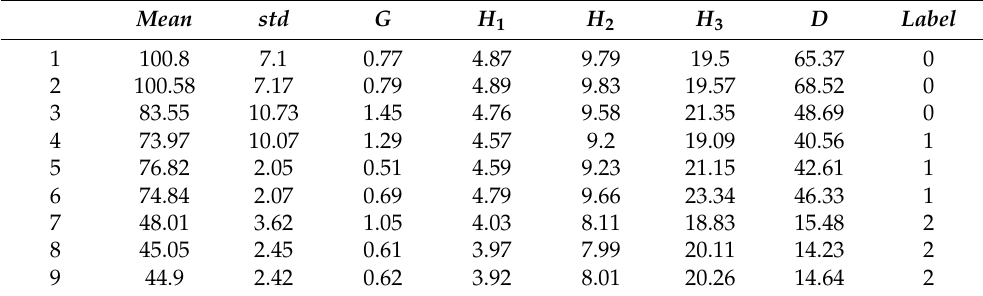
Table 1. Results of infrared feature extraction and the fault labels for the